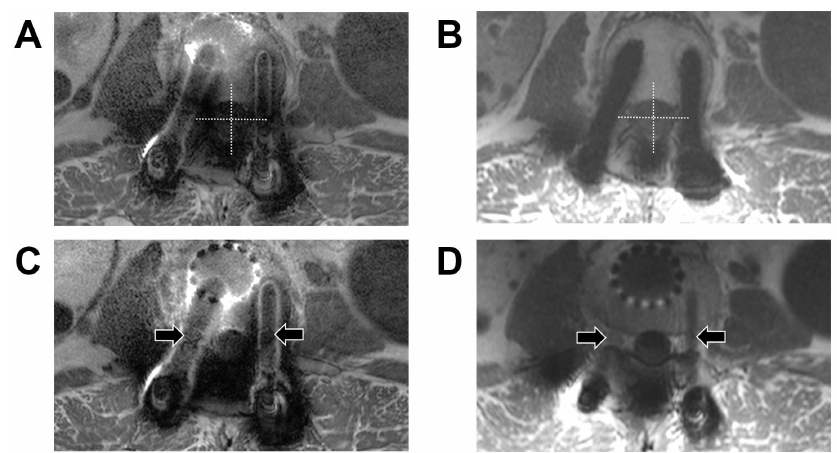
Fig 2. Visibility score of central canal and nerve roots in epidural space in axial images. These four axial images are obtained from a 68 year old male who underwentinter-body fusion at L4-5 and posterior instrumentation at L2-L5 level due to looseningof pedicle screws and infection of previous metallic implants which were inserted for L4 compressionfracture. The time interval between surgery and the spine MRI was 5 years and 10 months. Axial fast spin echo T1-weighted image after administration of contrast media (a) shows grade 0,1,0,0 (observer 1) and 0,0,0,0 (observer 2) of visibility of each quadrant of central canal at L3 level. (Right upper, left upper, right lower and left lower, respectively) FSE-SEMAC T1- weighted axial image after administration (b) of contrast media demonstrated grade 2,2,1,2 (observer 1) and grade 2,1,2,1 (observer 2) of each quadrantof central canal. Axial fast spin echo T1-weighted image after administrationof contrast media (c) shows grade 0,0 (observer 1) and grade 1,1 (observer 2) in right and left nerve root (arrows), respectively. After application of SEAMC technique,Axial FSE-SEMAC T1- weightedimage after administration of contrast media (d) demonstrated grade 3,2 (observer 1) and grade 2,2 (observer 2) in right and left nerve root (arrows), respectively.